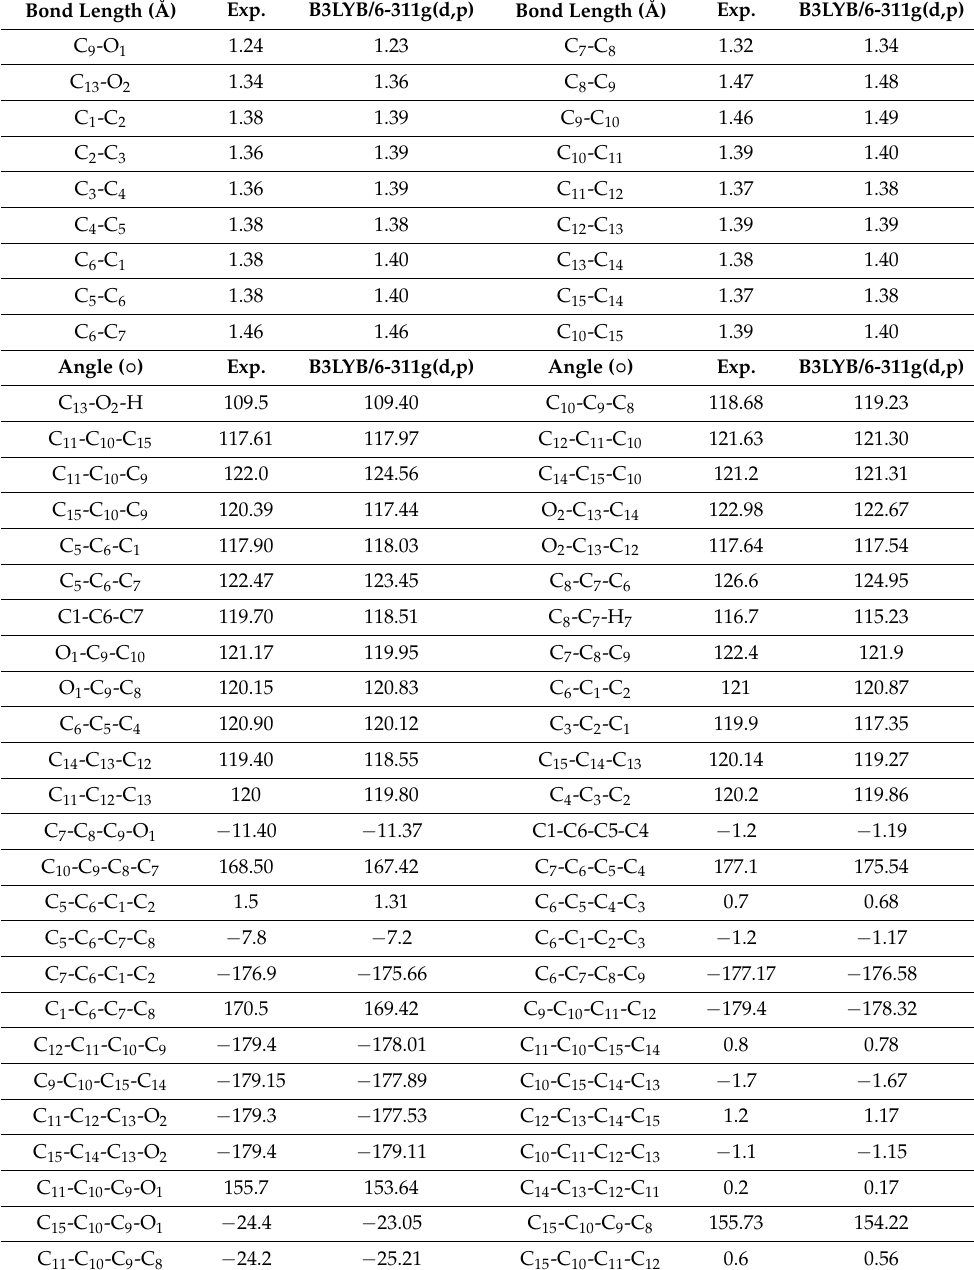
Table 2. The calculated and experimental values of selected structural parameters, bond lengths (Å), and bond angles ( ◦ ) of 1-(4-Hydroxyphenyl)-3-phenylprop-2-en-1-one. Bond Length (Å)